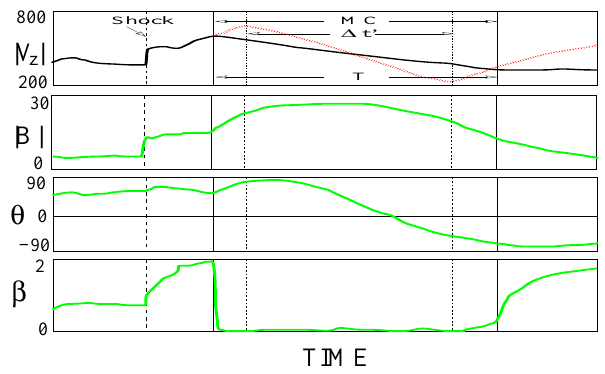
Fig. 1. A cartoon stressing the profile of the observed | V Z | ( ≡| V Z, CL | ) gradient of velocity as the spacecraft passes through a MC that is expanding; the subscript CL refers to the MC coordinate system (see Sect. 2), where the X CL -axis is aligned with the esti- mated local axis of the MC. Also shown (in green) are the magnetic field magnitude, field latitude angle, and proton plasma beta. The duration of the MC passage is T and the interval from the MAX to MIN of | V Z, CL | is 1t 0 . A upstream shock ramp is indicated for this MC, even though not all MCs possess upstream shocks. The red dashed curve for | V Z, CL | holds for a case where the MAX and/or MIN points for this quantity are markedly different from its values at the boundaries, and the black curve for | V Z, CL | holds for the case when its MAX and MIN values are at or very near to the